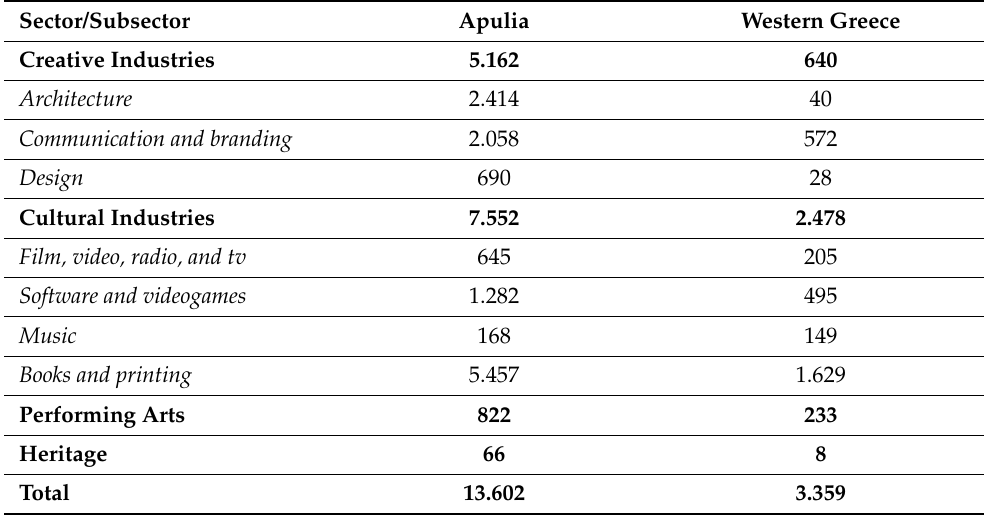
Table 1. Number of the mapped enterprises in CCs in Apulia and Western Greece. Sector/Subsector Apulia Western Greece